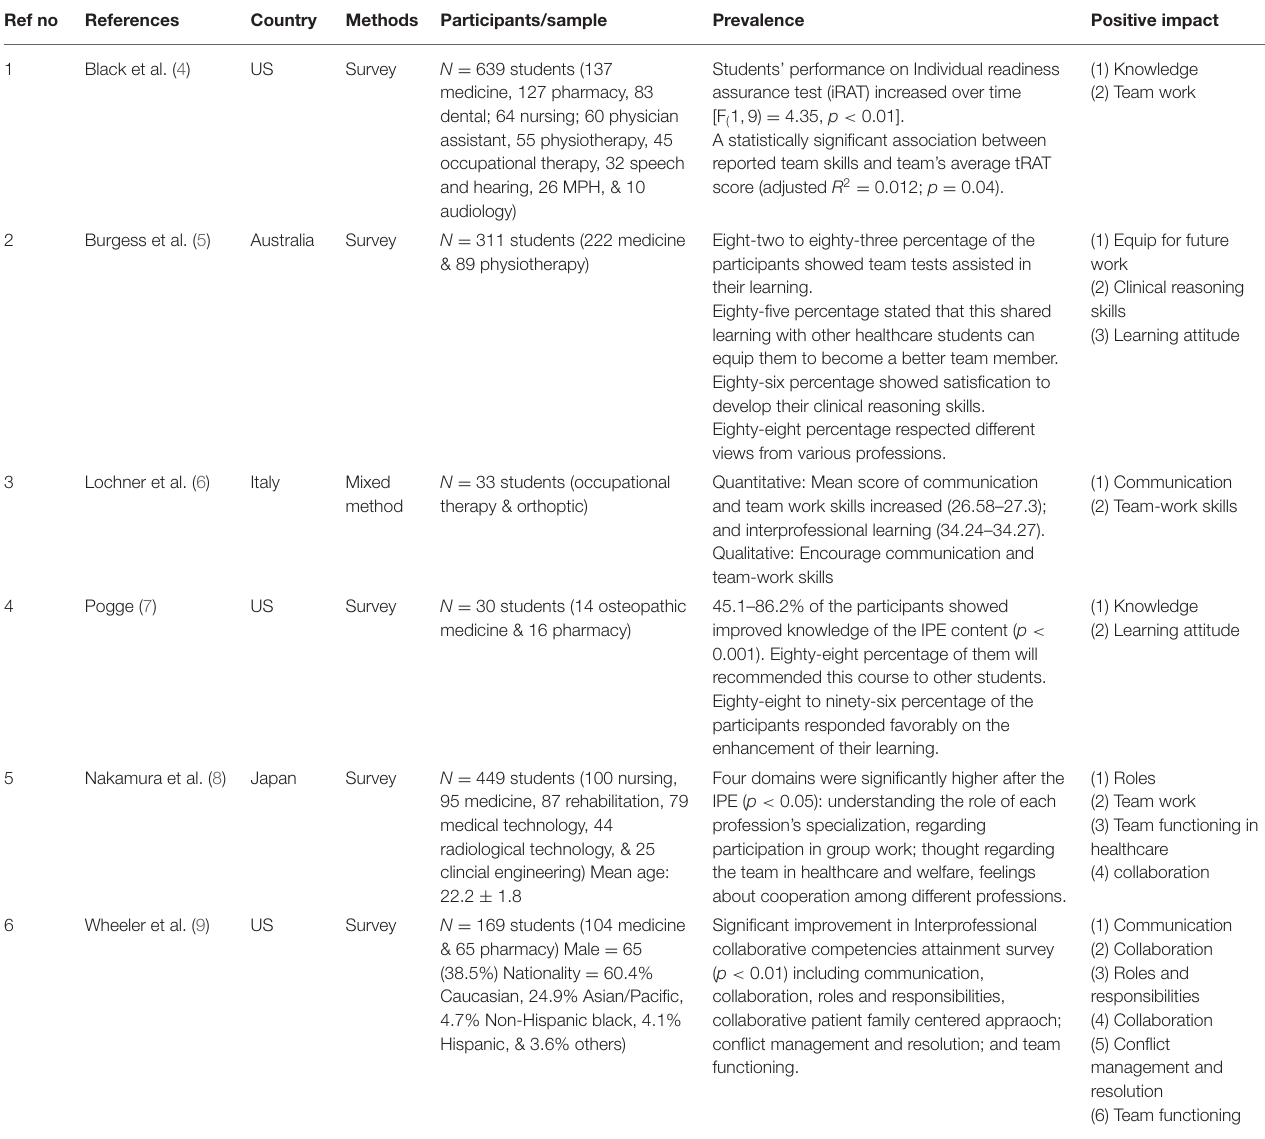
TABLE 1 | Description of studies on positive impact of interprofessional education in